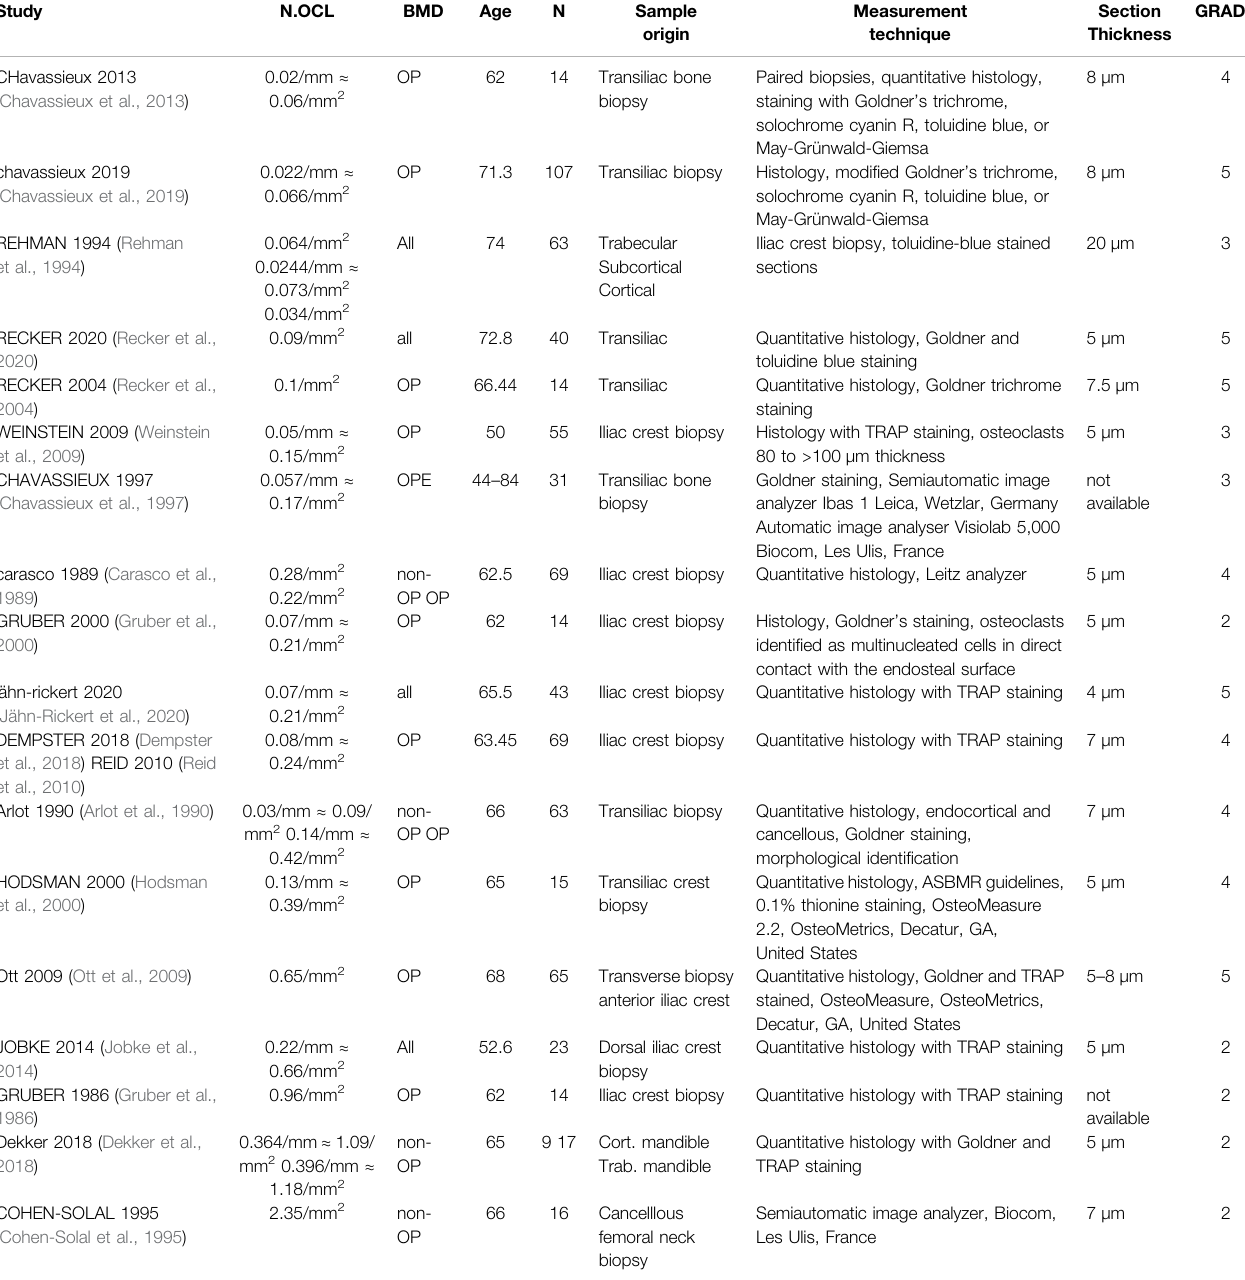
TABLE 10 | Osteoclast number measurements in postmenopausal women, in ascending order.